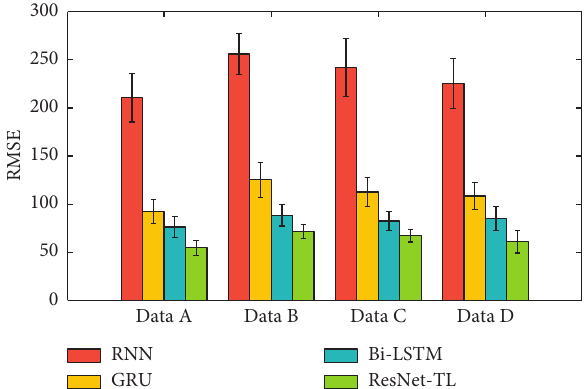
Figure 15: Confidence interval of RMSE for different methods. between 64.32 and 78.64 using the proposed framework Table 9 and Figure 15 show the color bars about the which is smaller than other methods, ranging between 65.17 confidence interval of the RMSE to evaluate the model and 87.13, which has verified the model learning ability from prediction ability of RUL. Results have shown that there is a historical sensor data. 95% likelihood that the RMSE of the predicted RUL ranges